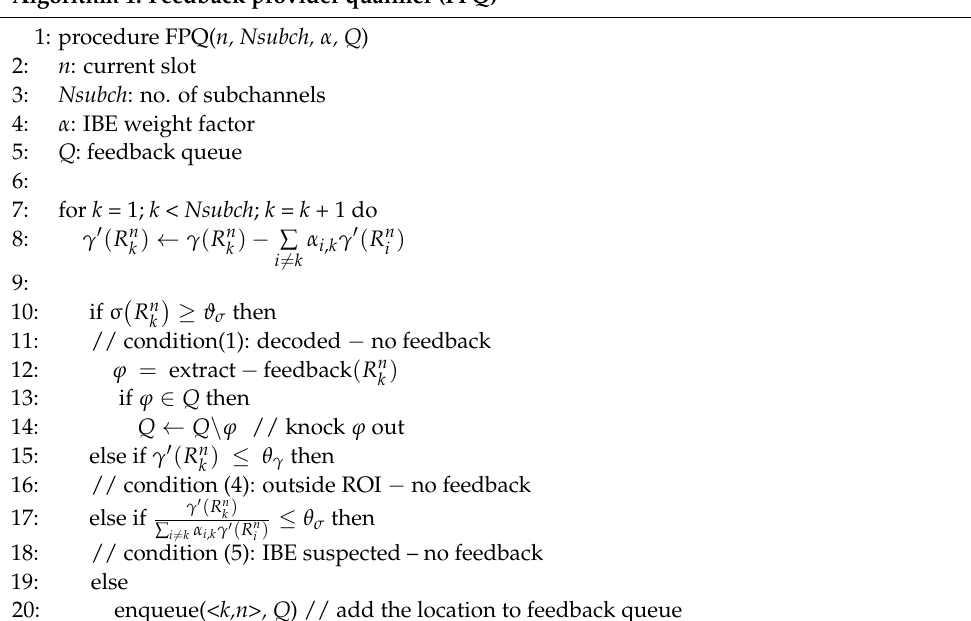
Algorithm 1. Feedback provider qualifier